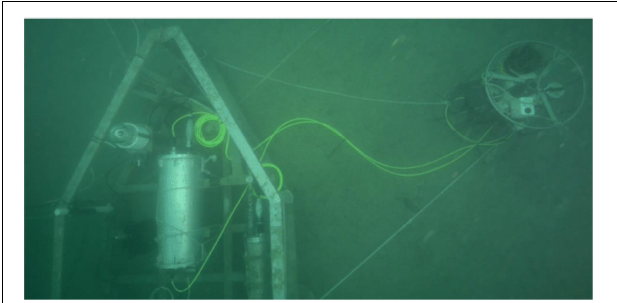
FIGURE 5 | The EGIM (right) connected to the OBSEA platform.